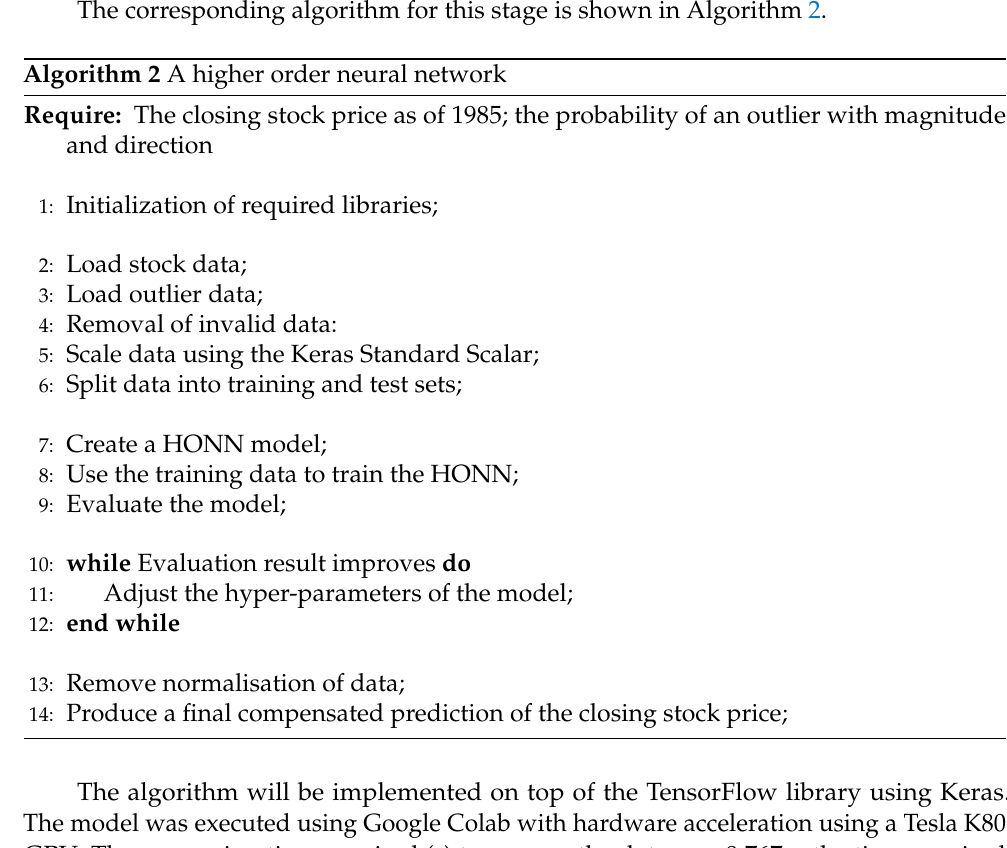
Algorithm 2 A higher order neural